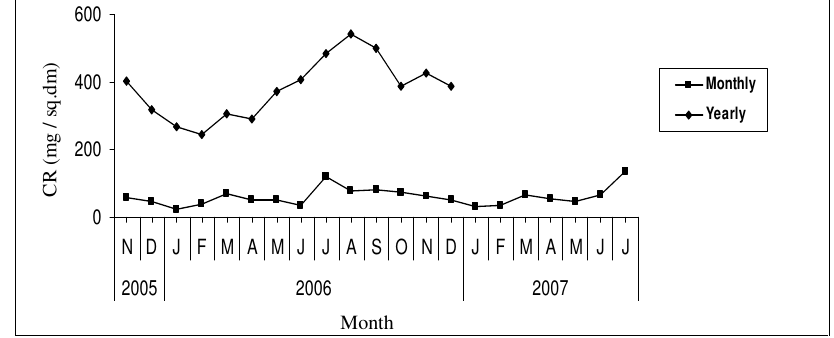
Figure 5 . Monthly and yearly corrosion rate of zinc under outdoor exposure during different months at marine environment. Table 1 . Atmospheric salinity (in mg NaCl/sq.dm) and sulphation rate (in mg SO